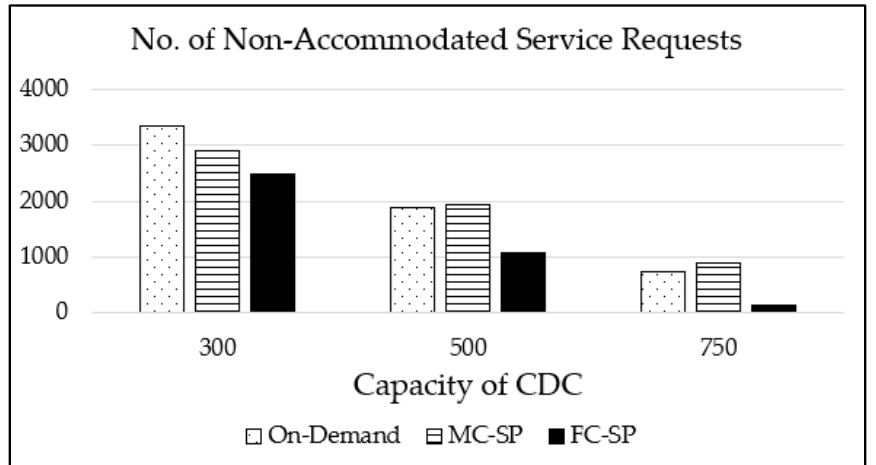
Figure 9. The number of non-accommodated service requests for various maximum CDC capacities with 1000 service types for the L distribution case.